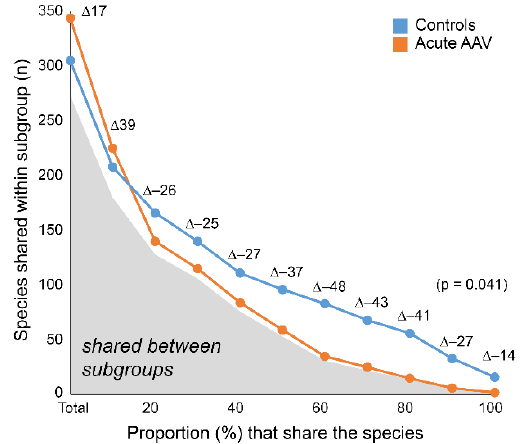
Figure 4. Shared species within and between subgroups. The number of species shared within acute AAV and controls by increasing sharing requirement. Gray area under the curve indicates the number of shared species between subgroups. Delta ( ∆ ) values reflect the difference in counts between acute AAV and control participants.